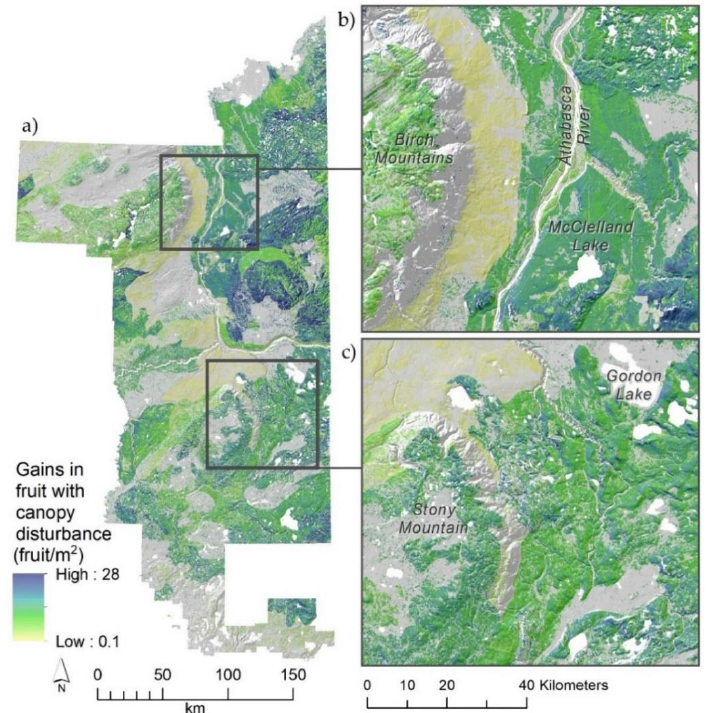
Figure 5. Velvet-leaf blueberry fruit production based on airborne LiDAR forest canopy cover (fraction of first returns >1.37 m height) ( a ) and predicted fruit production (fruit/m 2 ) for northeast Alberta, Canada ( b ). Note that parts of the study area (Cold Lake Air Weapons Range in the